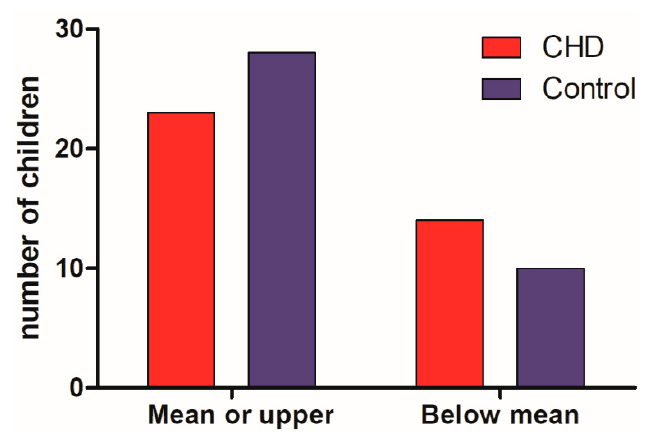
Figure 2. Children’s performance in the R-2 Nonverbal Intelligence test.